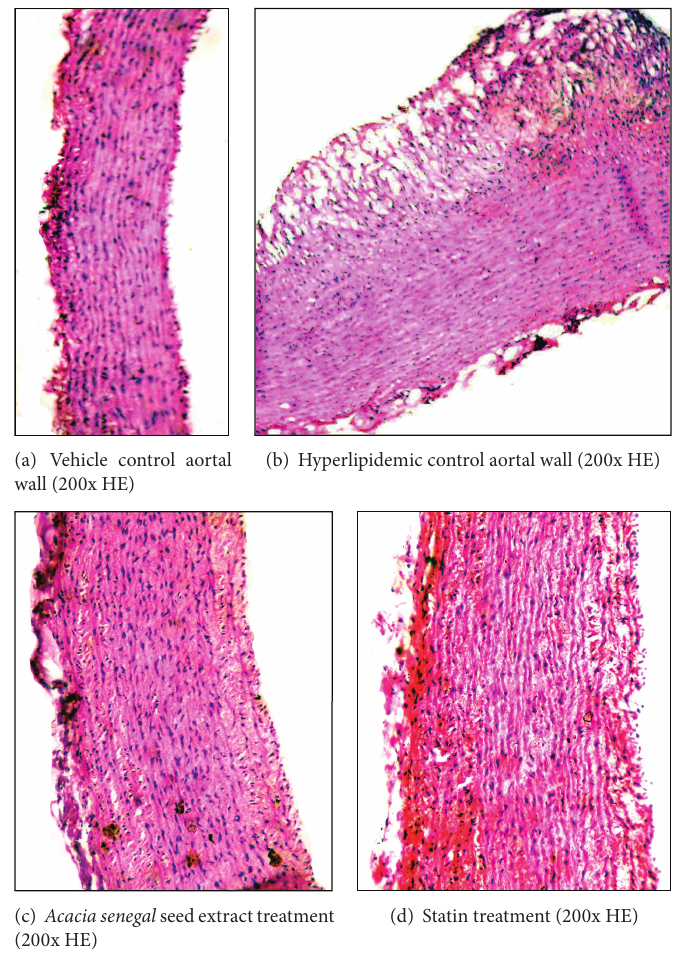
Figure 3: Effects of Acacia senegal seed extract (AS, 500 mg/kg/day, p.o.) or statin (0.25 mg/kg/day, p.o.) treatment for 45 days on the alteration in aorta wall in hypercholesterolemic (Chol) diet fed male rabbits (200x